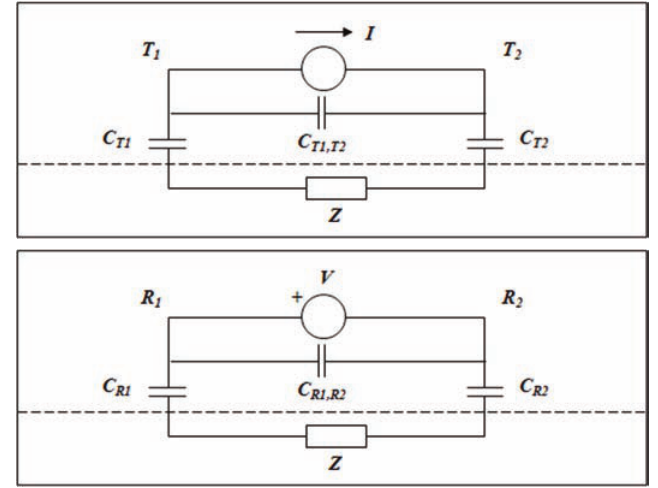
Figure 8. Equivalent capacitance circuits of the quadrupolar probe that schematize the transmission (a) and reception (b)